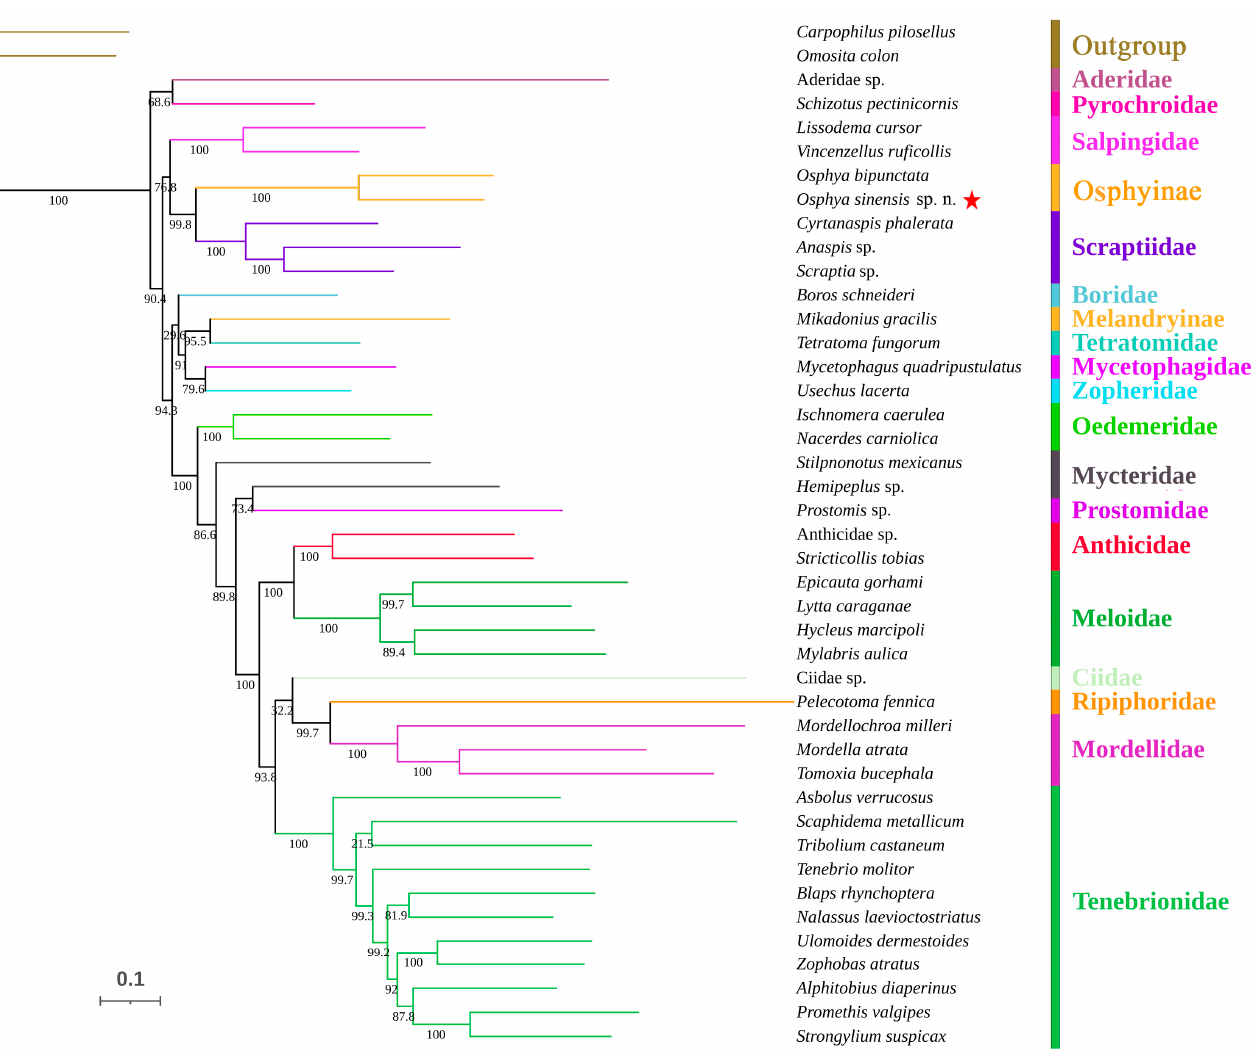
Figure 4. Phylogenetic tree of Tenebrionoidea produced from the ML analysis based on 13 PCGs (BS values indicated in each clade). The red star denotes Osphya sinensis sp. n.